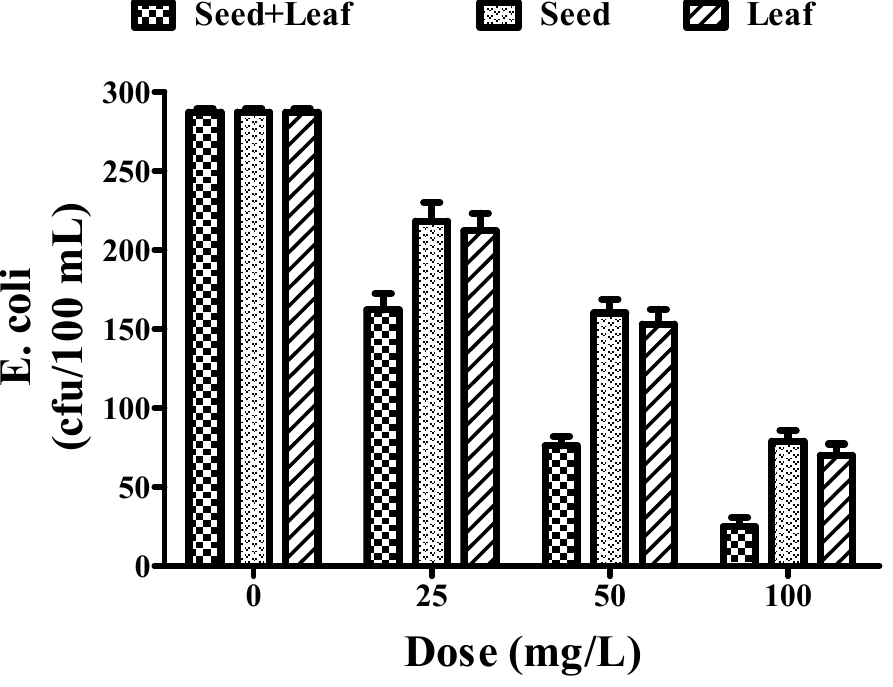
Figure 6. Comparative experimental analysis of combined and individual extracts of the Moringa oleifera plant on E. coli count in groundwater at different doses (25–100 mg/L). All experiments were done three times in triplicates and presented as mean ± SEM.